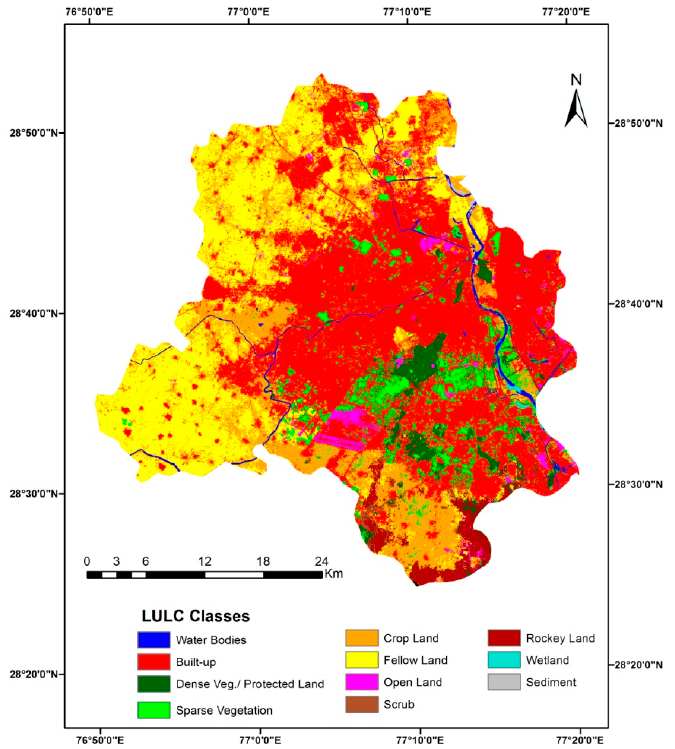
Figure 2. Land use/Land cover map of the study area.